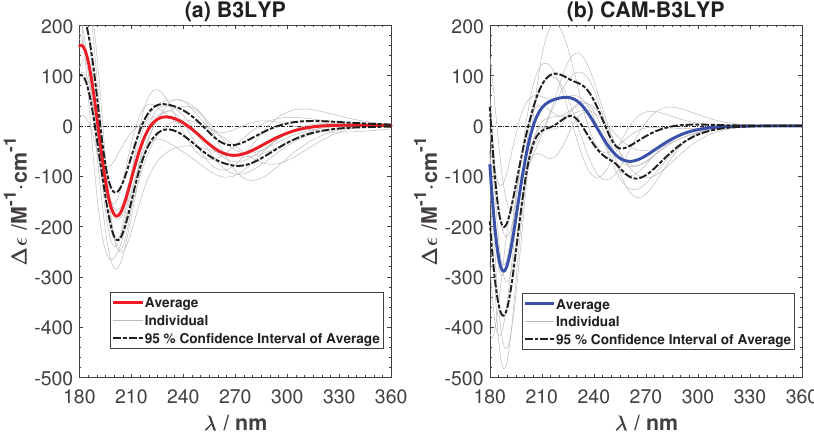
Figure 4. The average and individual ECD spectra of ten sampled structures with B3LYP ( a ) and CAM-B3LYP ( b ). Spectra are not shifted, but presented as